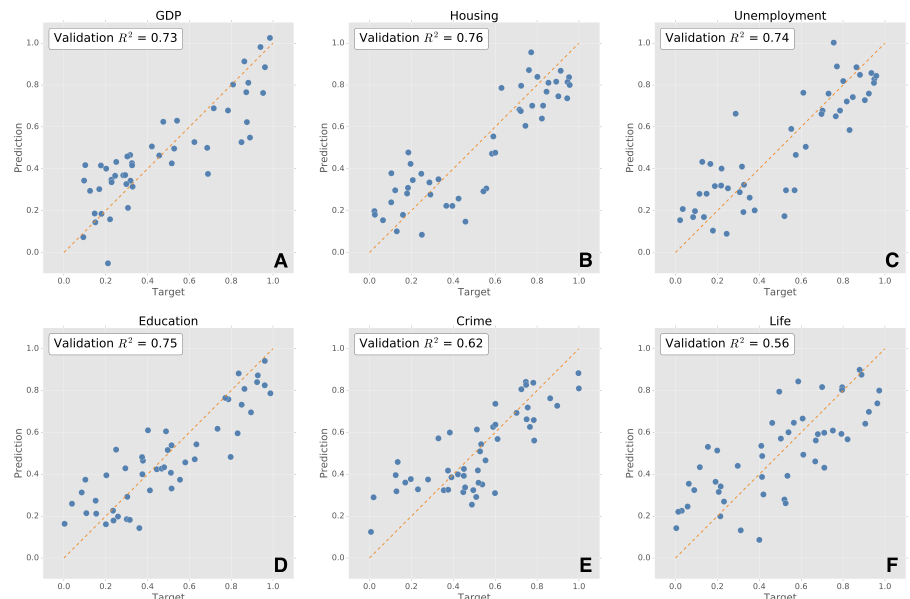
Fig 4. Outcome of predictive modeling of official socioeconomic indicators based on individual transactions. Each subplotshows the performance of the proposed methodology to predict six official socio- economicfeatures (target). The prediction is basedon commercialindicesbuilt upon financialtransactions and employingan iterative methodology, which takes advantage of PCA, support vector machines. The orangedotted lines indicate the ideal prediction.